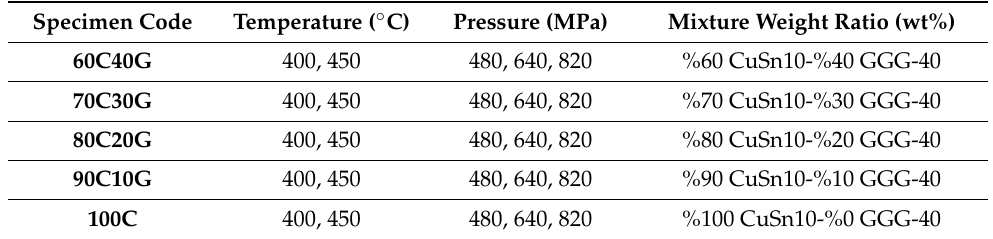
Table 2. Composite material production